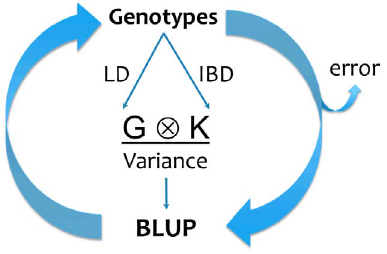
Figure 1.The mechanism and performance of iBLUP. The figure illustrates how observed genotype with missing value is imputed by Best Linear Unbiased Prediction (BLUP). The imputation uses both relationship among markers represented by Linkage Disequilibrium (LD), and relationship among individuals represented as Identity By Decent (IBD).G and K are the genetic variance–covariance matrix and marker-based kinship matrix respectively, and the symbol 6 represents the Kronecker